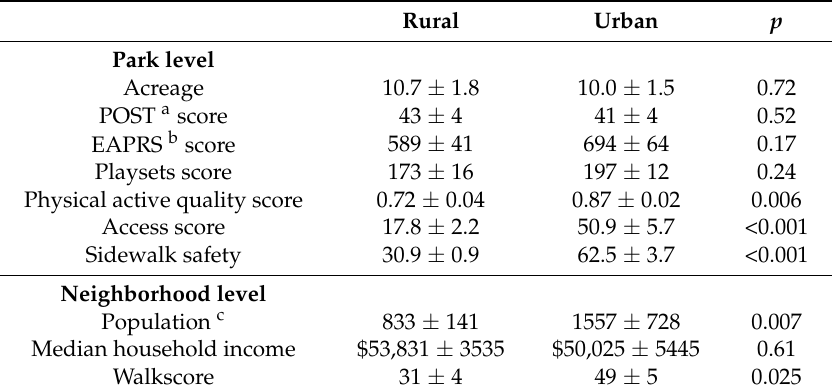
Table 2. Park and neighborhood level characteristics of rural and urban settings.